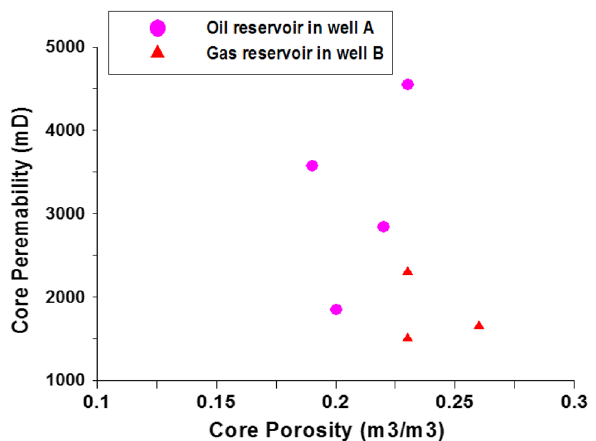
Fig. 8 Crossplot between predicted permeability from Buckles’ approach and core porosity for the Well-A and Well-B at selected depth